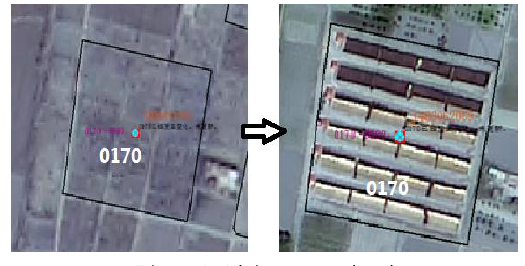
Figure 2. Object not updated